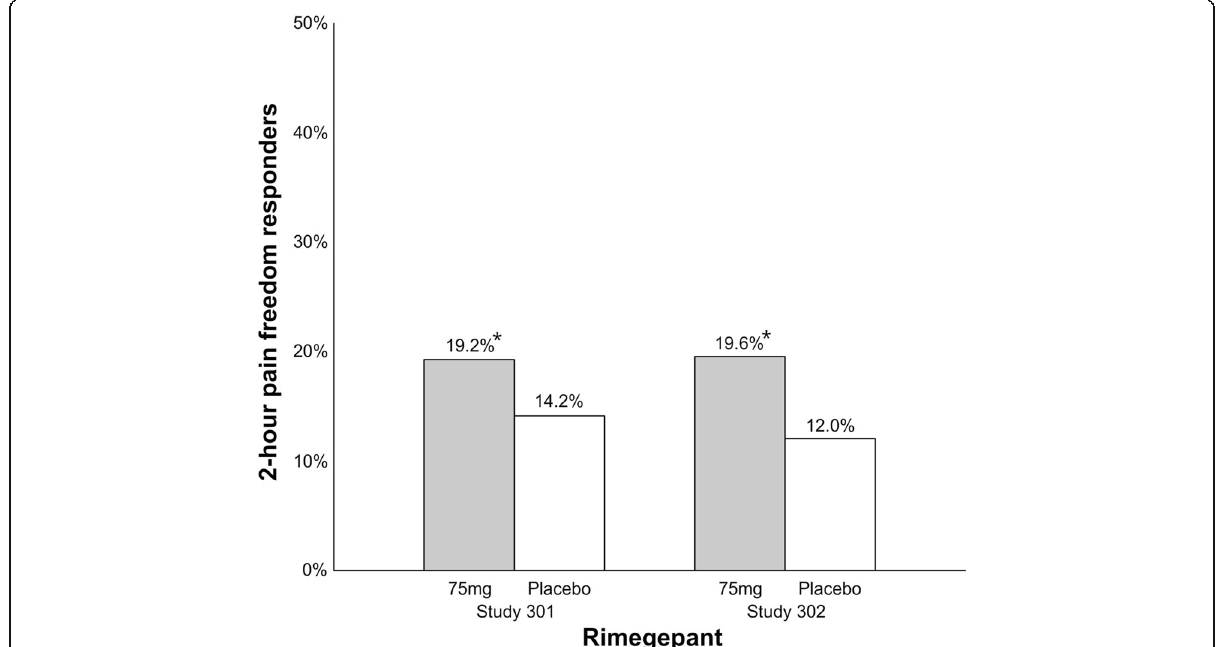
Fig. 4 Overview of patients (%) achieving 2-h pain freedom in rimegepant phase III clinical trials. *Study 301; vs. placebo, p < 0.003. Study 302; vs. placebo, p < 0.001